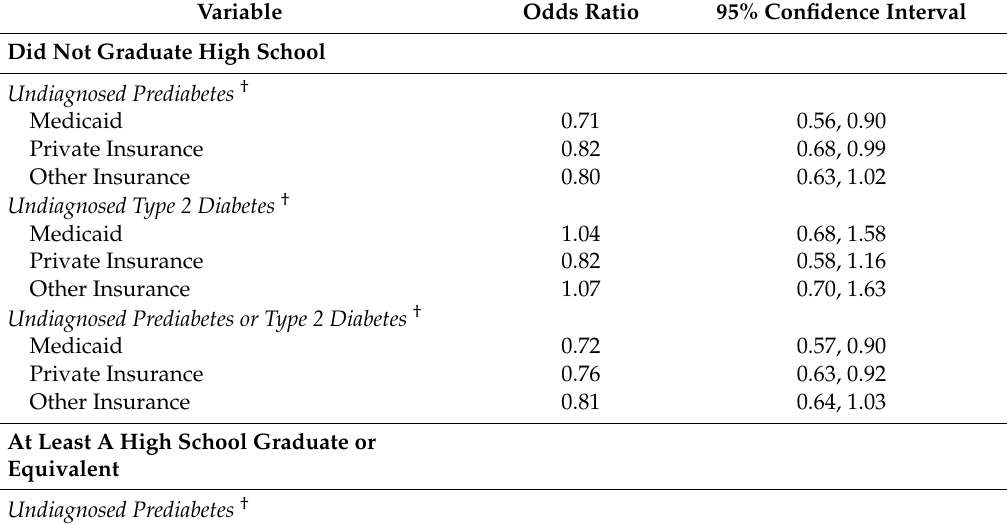
Table A2. Associations of health insurance type and undiagnosed prediabetes and type 2 diabetes stratified by educational achievement and race /